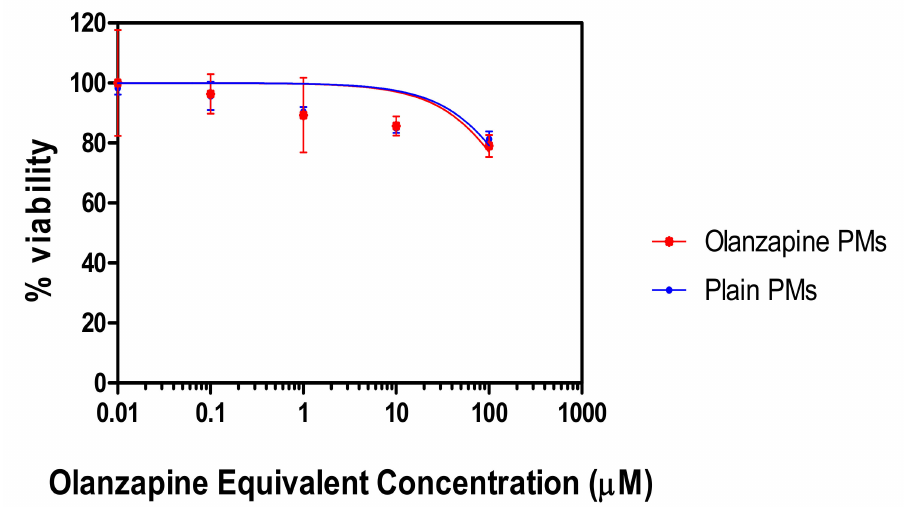
Figure 8. In vitro cytotoxicity of OZ polymeric micelles on Calu-3